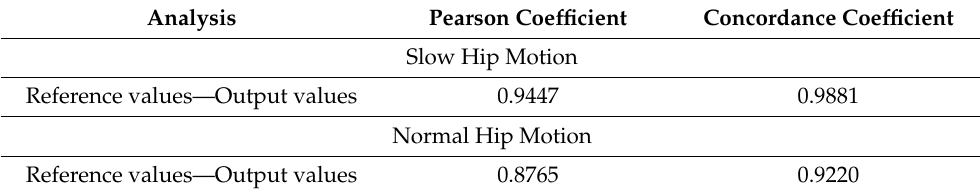
Table 1. Analysis of slow and normal hip motion.